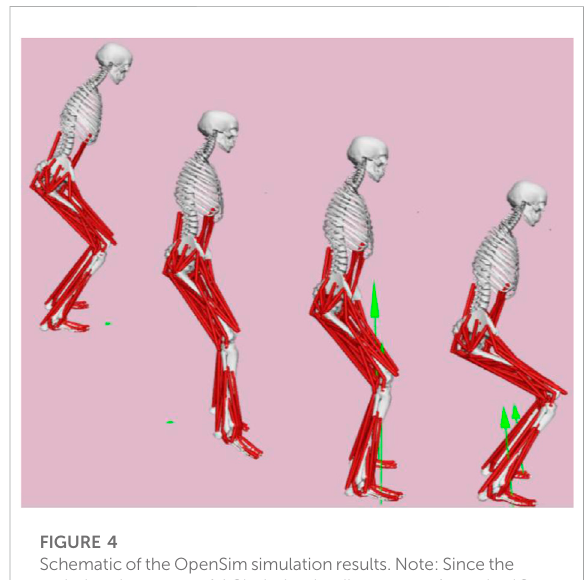
FIGURE 4 SchematicoftheOpenSimsimulationresults.Note:Sincethe main bearing stage of ACL during landing occurs from the IC to MKF, the simulation results of the three landing test actions in this studyweretakenduringtheIC-MKF(0% –